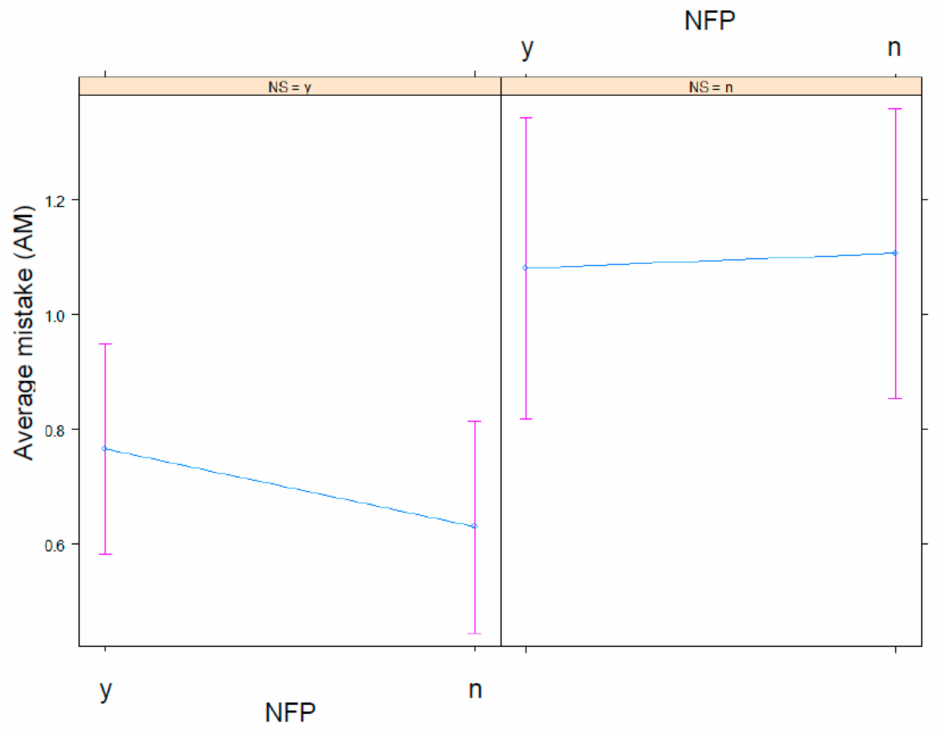
Figure 3. Impact of Nutri-Score (NS: n = no (0); y = yes (1)) and NFP presence (n = no (0); y = yes (1)) on AM in the healthfulness estimation